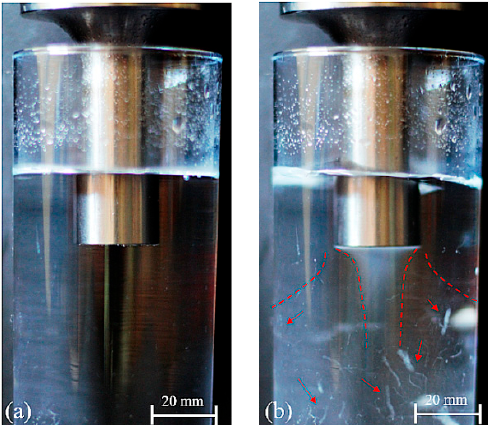
Figure 9. Photograph of resonance cavitation field in the experimental container (400 W): ( a ) No-US, ( b ) with US activated.